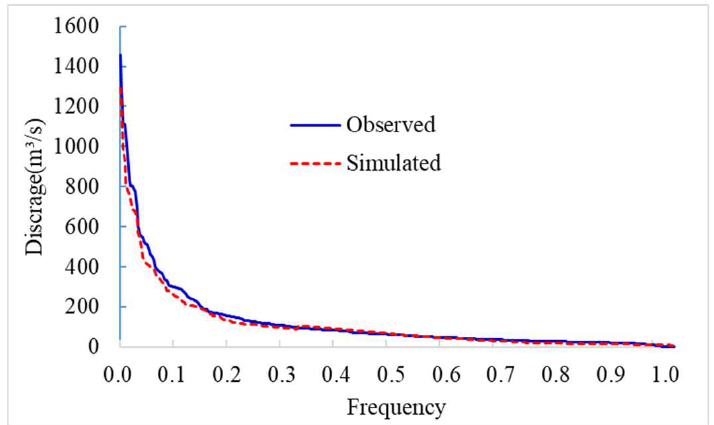
Figure 5. The daily flow duration curves of the catchment.